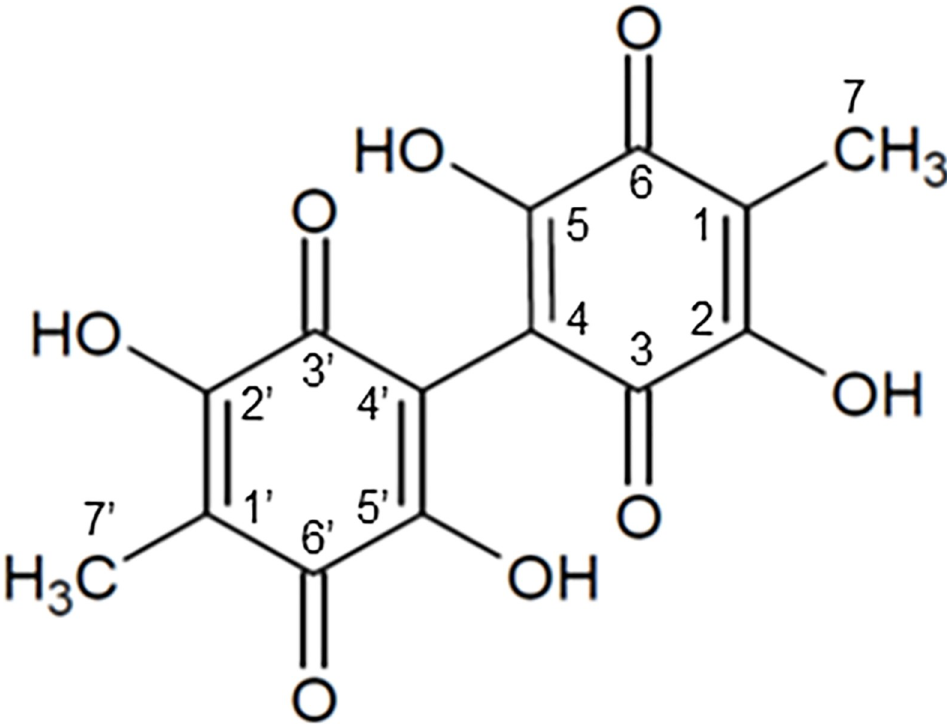
Fig 2. Chemical structure of oosporein. Carbons are numbered according to He et al. [37].